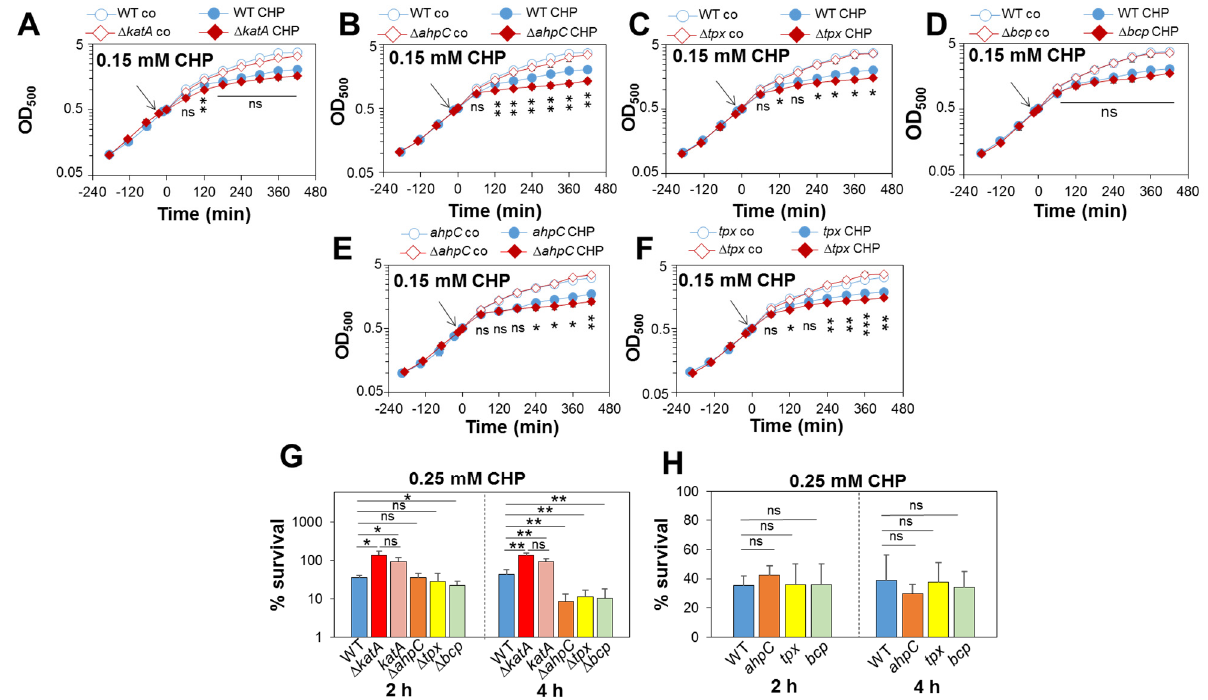
Figure 6. The peroxiredoxins AhpC, Tpx and Bcp contribute to CHP resistance in S. aureus . ( A – F ) Growth phenotypes were analysed for the S. aureus COL WT, ∆ katA ( A ), ∆ ahpC ( B ), ∆ tpx ( C ) and ∆ bcp mutants ( D ) and the ahpC ( E ) and tpx ( F ) complemented strains in RPMI medium before (co) and after exposure to 0.15 mM CHP stress at an OD 500 of 0.5. ( G , H ) The survival rates of the S. aureus COL WT, ∆ katA , ∆ ahpC , ∆ tpx and ∆ bcp mutants ( G ) and the katA ( G ), ahpC , tpx and bcp ( H ) complemented strains were determined at 2 and 4 h after exposure to 0.25 mM CHP relative to the untreated control, which was set to 100%. Mean values and SD of four to six biological replicates are presented. The statistics were calculated using Student’s unpaired two-tailed t-test in Graph Prism. Symbols: ns p > 0.05, * p ≤ 0.05, ** p ≤ 0.01 and *** p ≤ 0.001.